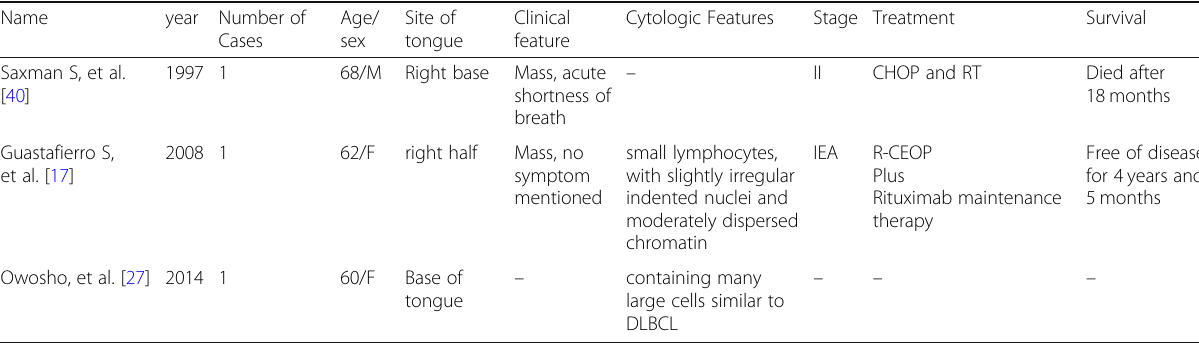
Table 4 Literature review of mantle cell